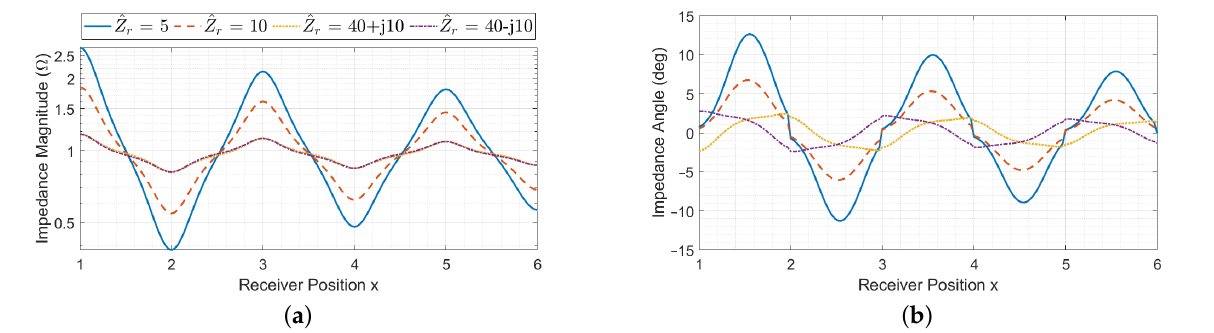
Figure 8. Array input impedance as a function of the receiver position with matched termination for different values of the receiver impedance ˆ Z r , in magnitude ( a ) and phase ( b ).